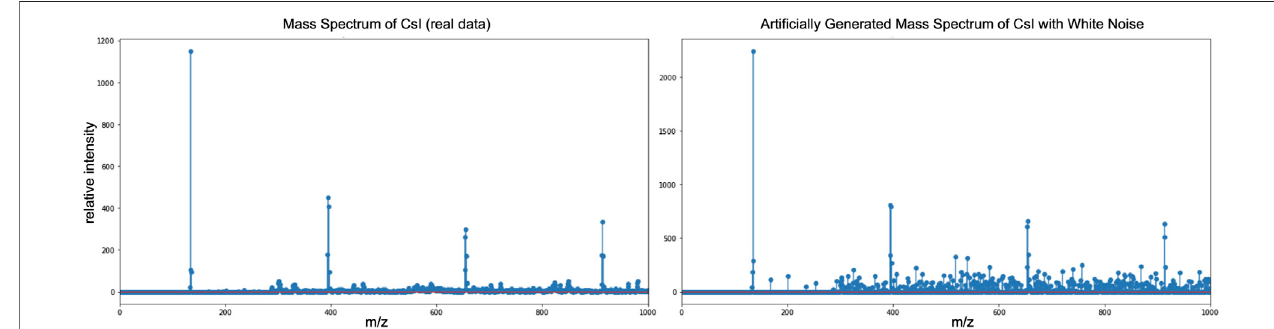
FIGURE7| Arti fi cialmassspectrum(right)created byaddingGaussiannoiseontherealmassspectrum (left).Noiseformassspectrometry experimentscaneither be from 1 ) the instrument ’ s noise or from 2 ) the chemistry noise. For ML training it is often useful to add noise to the input data to reduce over fi tting (e.g., when the algorithm is able to learn the training data too